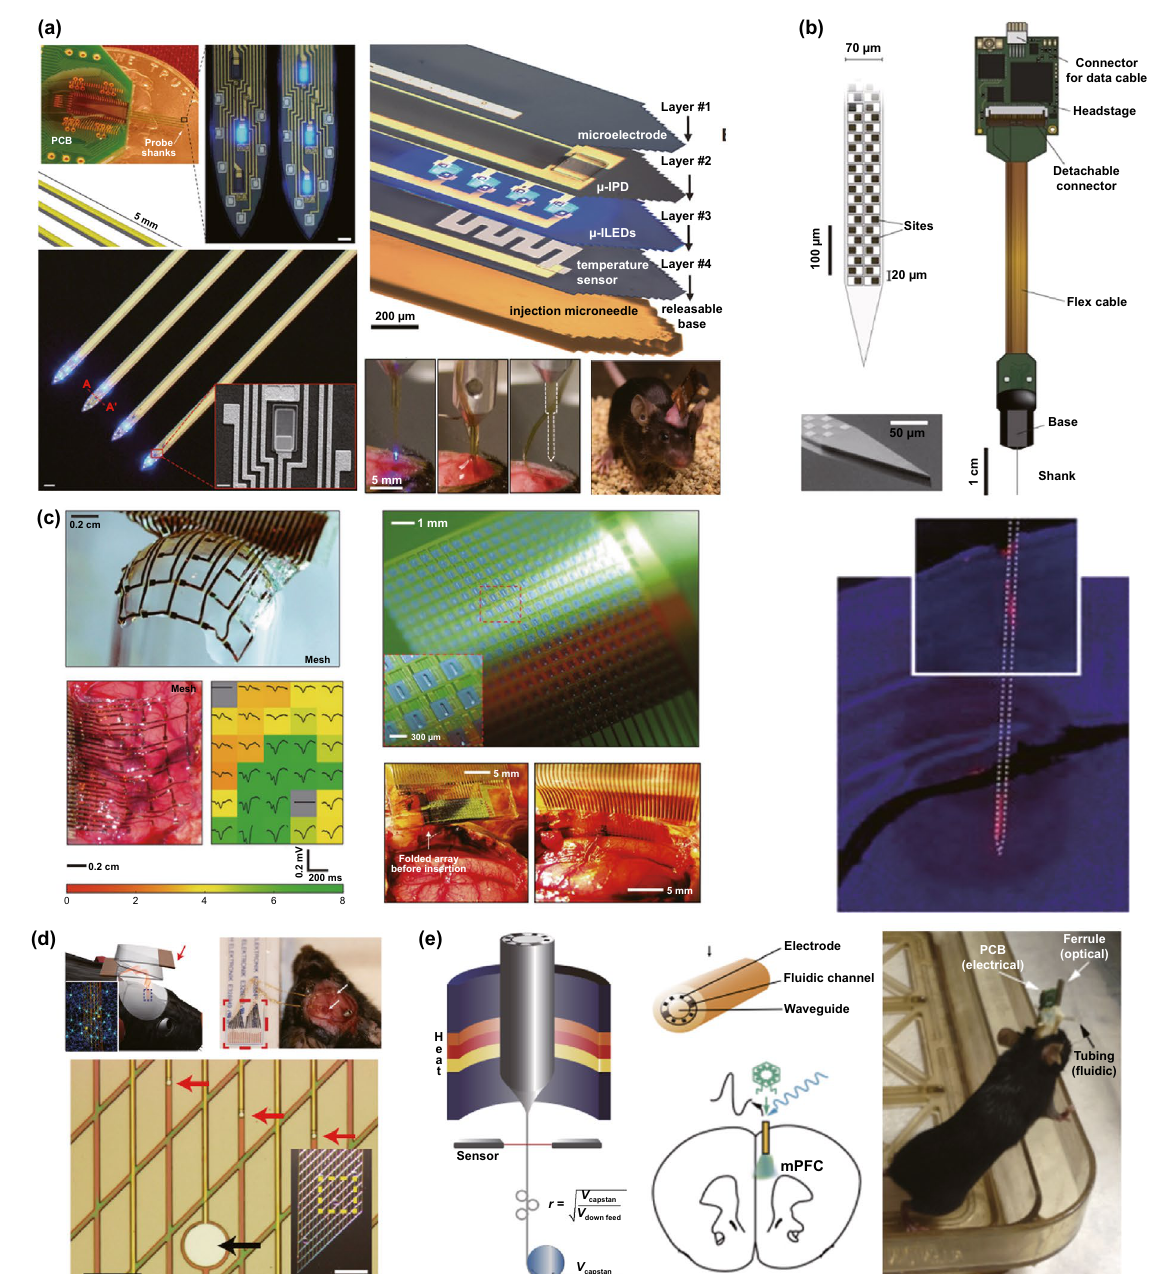
Fig. 17 a Optical component integrated multifunctional Michigan electrodes for optogenetic applications [301, 302]. b Microchannel integrated Michigan electrodes for drug delivery (Top) and CMOS‑based high‑density recording of neural activities (Bottom) [303]. c Flexible electrode array for ECoG and intracortical signal recording [304, 305]. d Injectable mesh electrodes for long‑term brain mapping and neural recording [306]. e Multifunctional FEAs for simultaneous optical stimulating, electrical recording, and drug delivering of neural circuit in vivo [307, 308]. Reproduced with permission from Refs. [301–308], copyright (2015) Cell Press Publishing Group, (2013) Science Publishing Group,